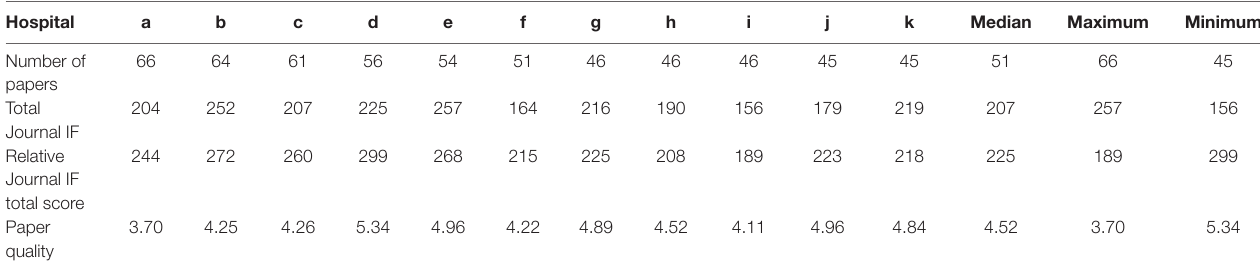
TABLE 3 | Quality of papers by medical institution.